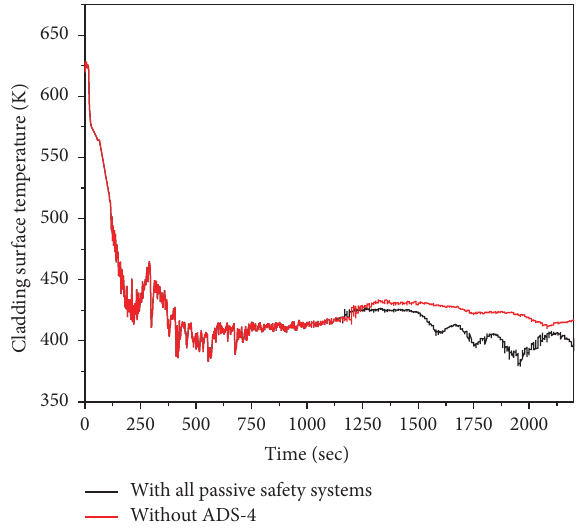
Figure 19: Comparison of cladding surface temperature in case-1 and